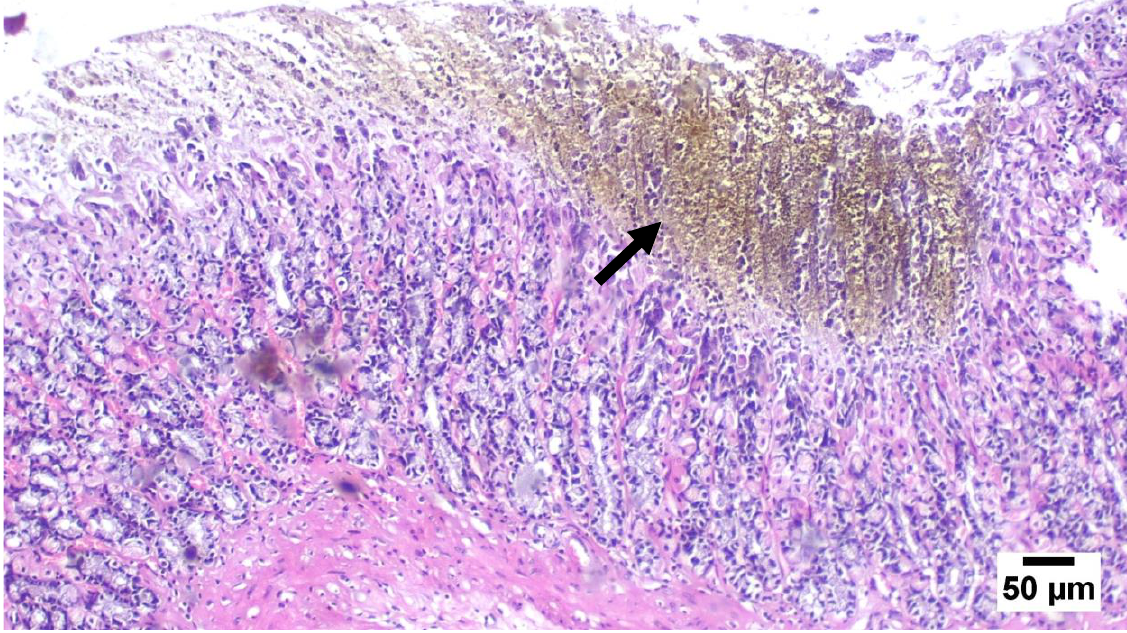
Figure 14. Photomicrograph of stomach, aspirin group, showing extensive mucosal damage, hemorrhage (arrow) (H&E).